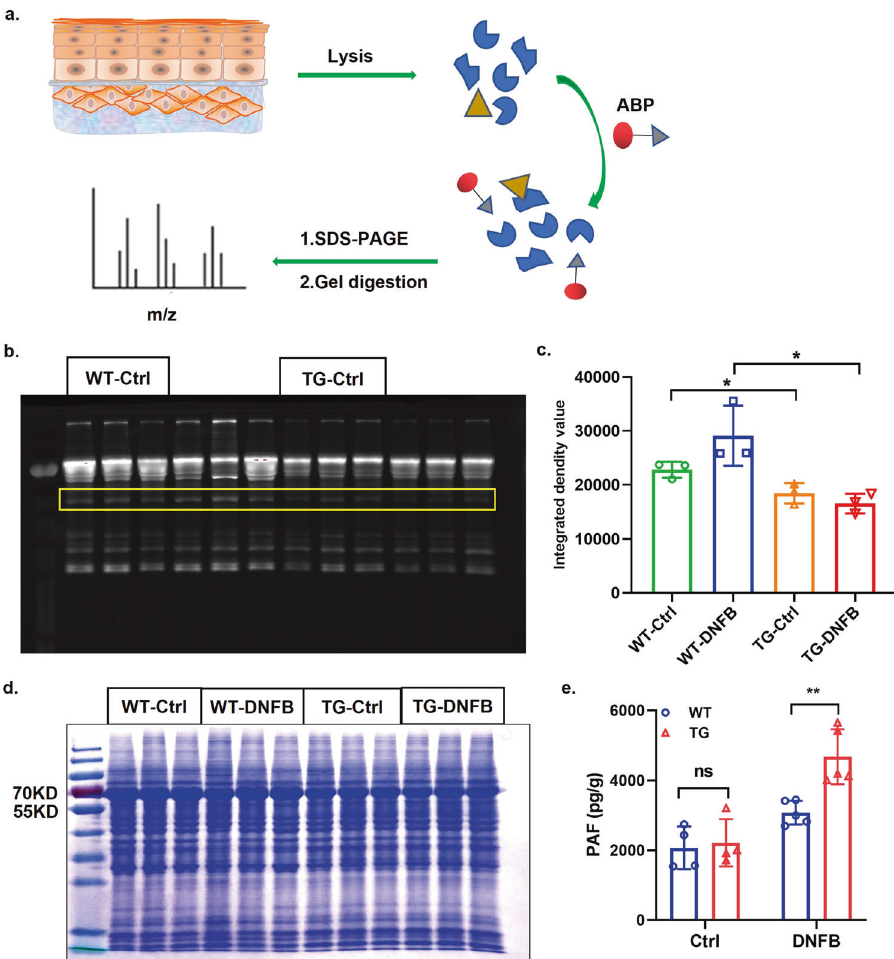
Fig. 7 WFDC12-expressing accelerates the activity of serine hydrolase strengthen and the accumulation of PAF. a Schematic diagram of enzyme activity detection with the probe with serine hydrolase binding activity. ABP activity-based probe. b The gel fl uorescence imaging of serine protease activity in mice epidermis. c Quantitative analysis of serine protease activity. d Coomassie brilliant blue staining analysis of proteins in the epidermis. e The content of PAF in mice